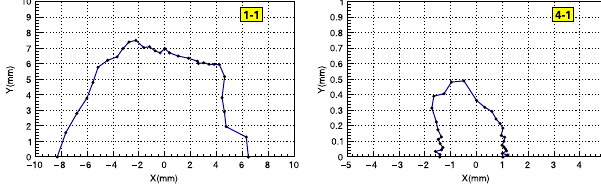
FIG. 10. TME cell emittance for different u. The red line indicates minimum emittance equal to 75 pm with parameters from Table I.